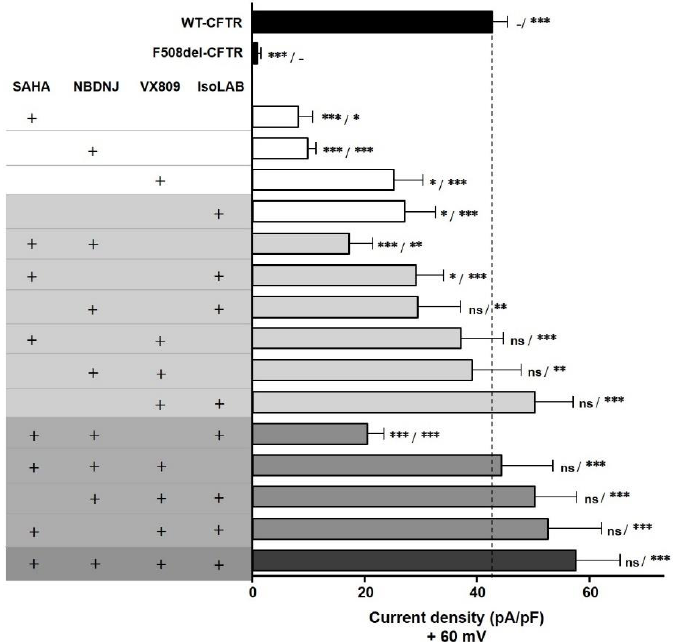
Figure 17. Effect on the F508del-CFTR rescue after application of several correctors individually or in combinations. * p < 0.05; ** p < 0.01; *** p < 0.001; ns, not significant. This figure is adapted with permission from